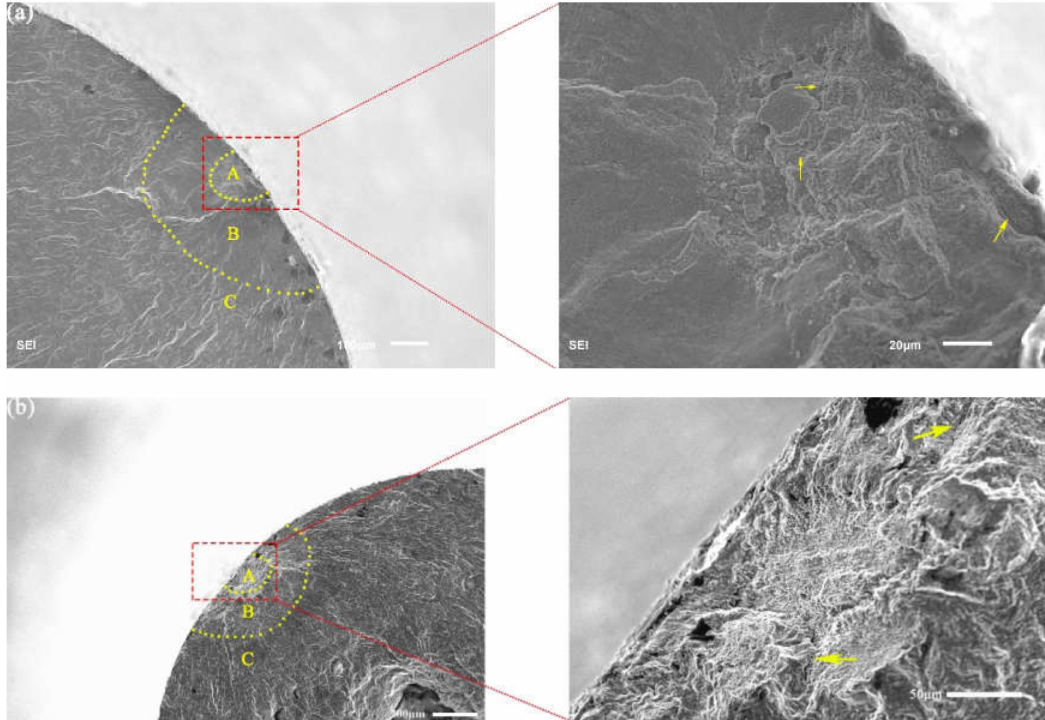
Figure 9. Typical fracture morphology of failure specimen with surface-induced. ( a ) R = − 1, σ a = 130 MPa, N f = 2.59 × 10 8 cycles and ( b ) R = 0.1, σ a = 63 MPa, N f = 2.79 × 10 8